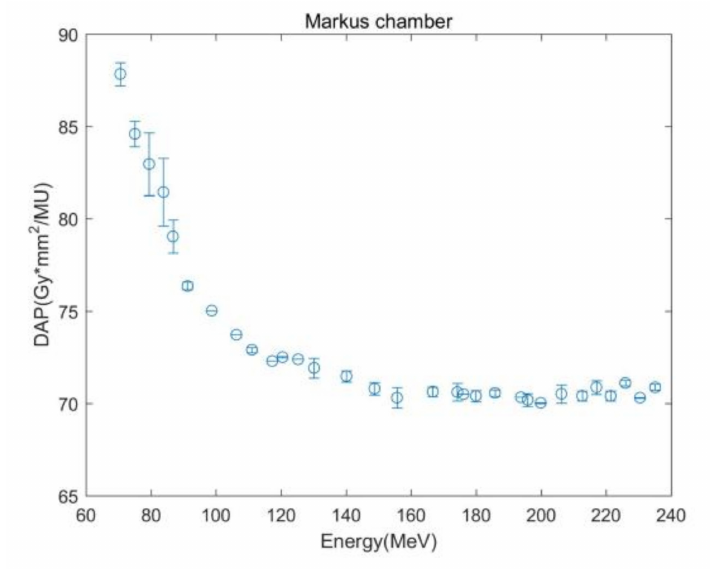
Figure 5. DAP of 32 different energies measured by the single-layer method with the Markus chamber. Comparison of DAP measured with MC and BPC is shown in Figure 6. The error bar demonstrates the standard deviation from the repeating measurements. Mean DAP is the average of DAP measured with MC and BPC (Table 1). The percentage difference illustrates the discrepancy of DAP measured with BPC to that with MC, ranging from − 0.19% to 1.26%. The single-layer method can be used as reference dosimetry. The percentage difference between DAP measured with the BPC and MC ranges from − 2.5% to 0.39%. The largest deviation occurred at energy 83.8 MeV due to the instability of scanning field at low energy during the commissioning stage of SAPT.